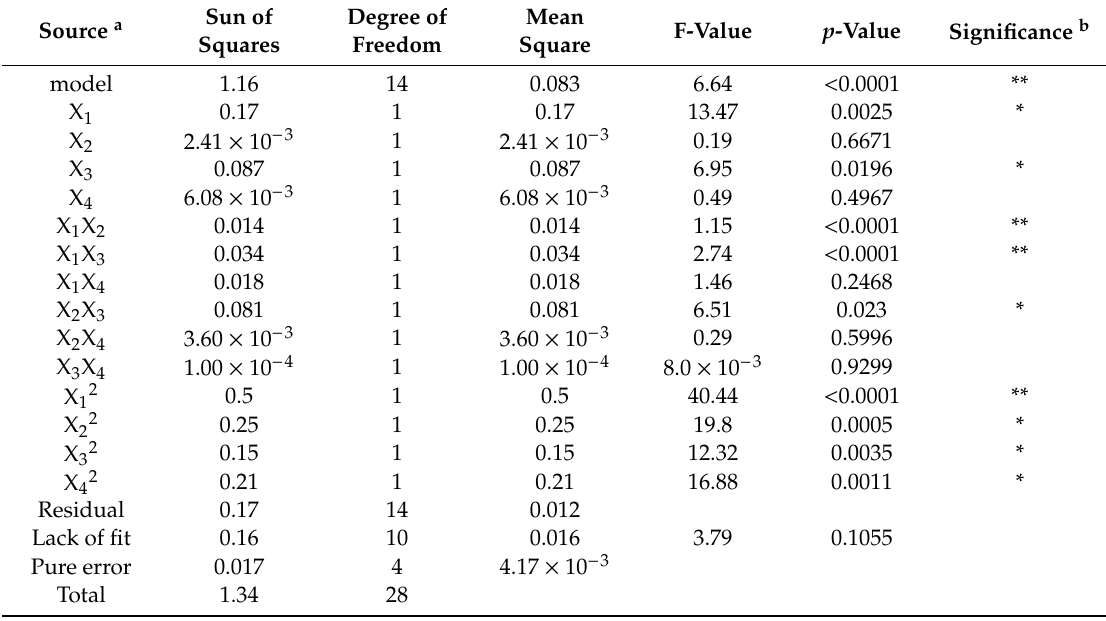
Table 3. Results of response–surface variance analysis of TCBL polysaccharide yield. Sun of Source a